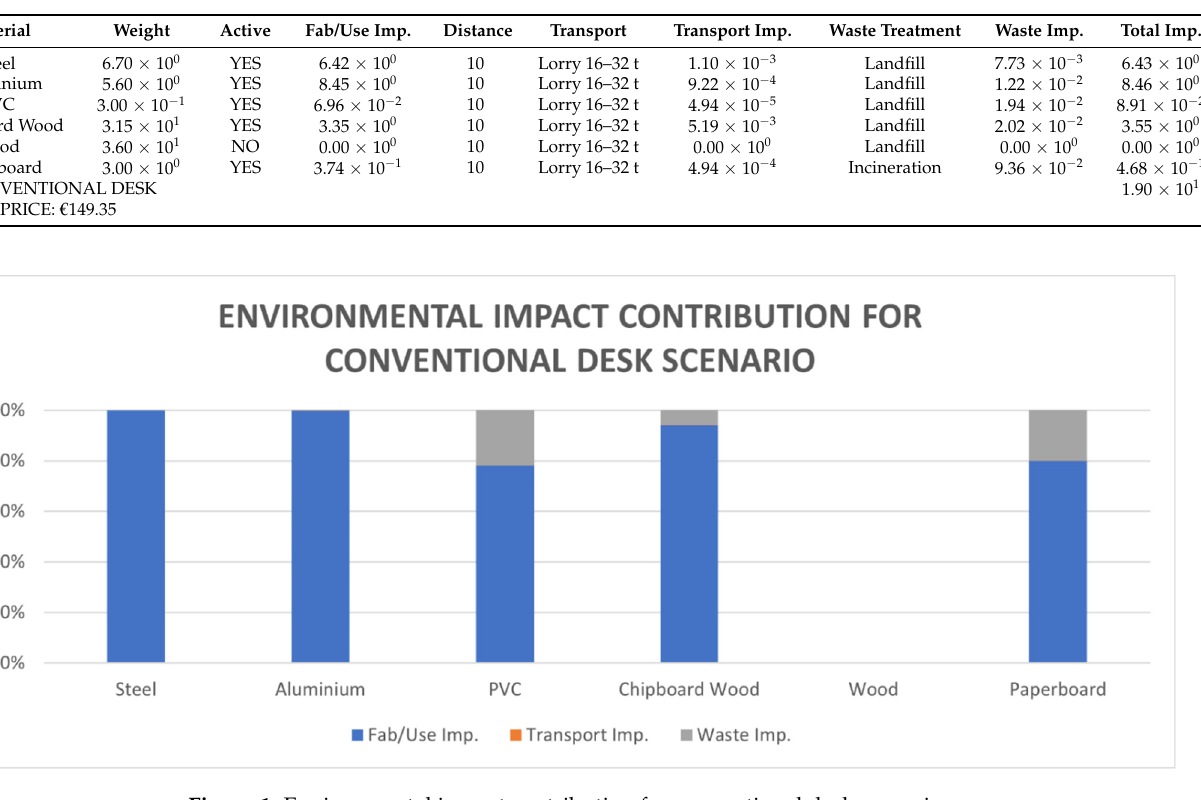
Table 9. Results of American wood desk scenario.